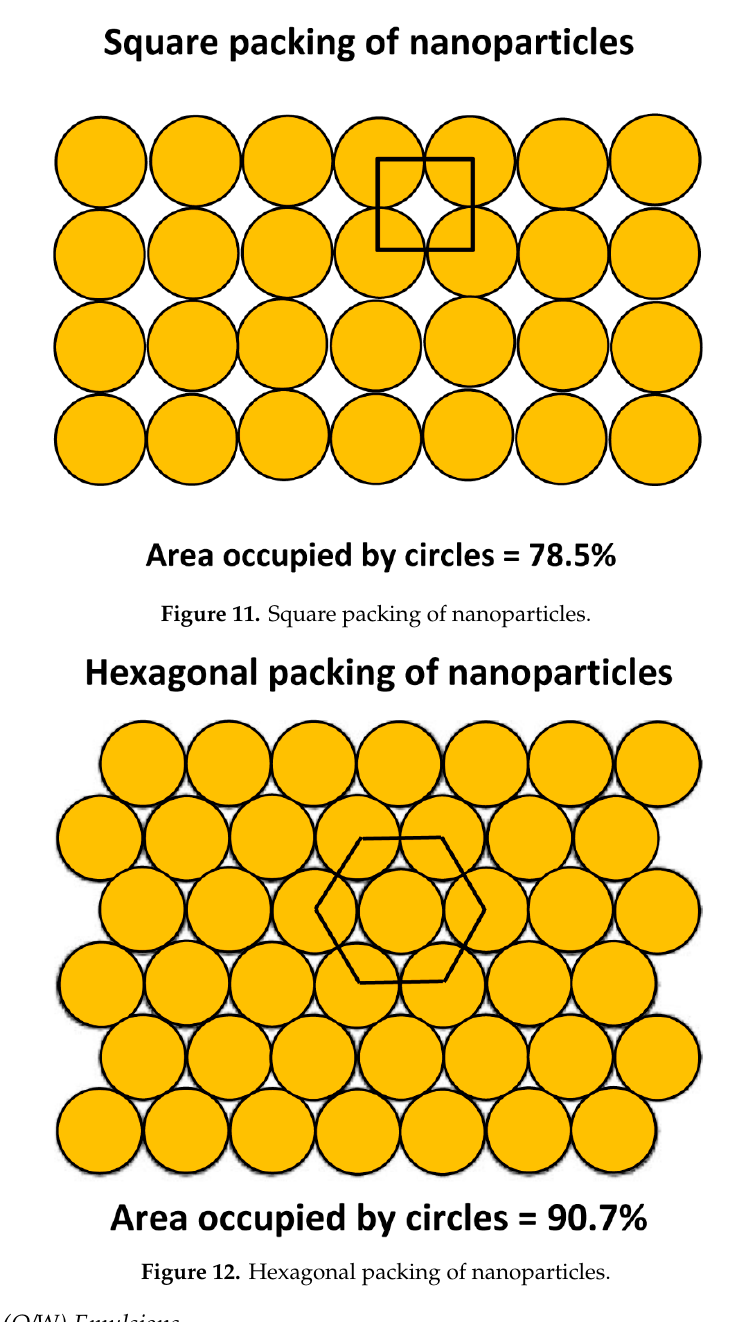
Figure 13. Thickness of interfacial layer of solid nanoparticles protruding into the continuous phase of an emulsion. where 𝑅 (cid:3031) is the radius of bare emulsion droplet (see Figure 10). The mass of nanoparticles present on the surface of a single oil droplet can be calculated as follows: 𝑚 (cid:3041)(cid:3028)(cid:3041)(cid:3042)(cid:3043)(cid:3028)(cid:3045)(cid:3047)(cid:3036)(cid:3030)(cid:3039)(cid:3032)(cid:3046) = 𝑁𝜌 (cid:3041)(cid:3043) (4𝜋𝑅 (cid:3041)(cid:3043)(cid:2871) /3)